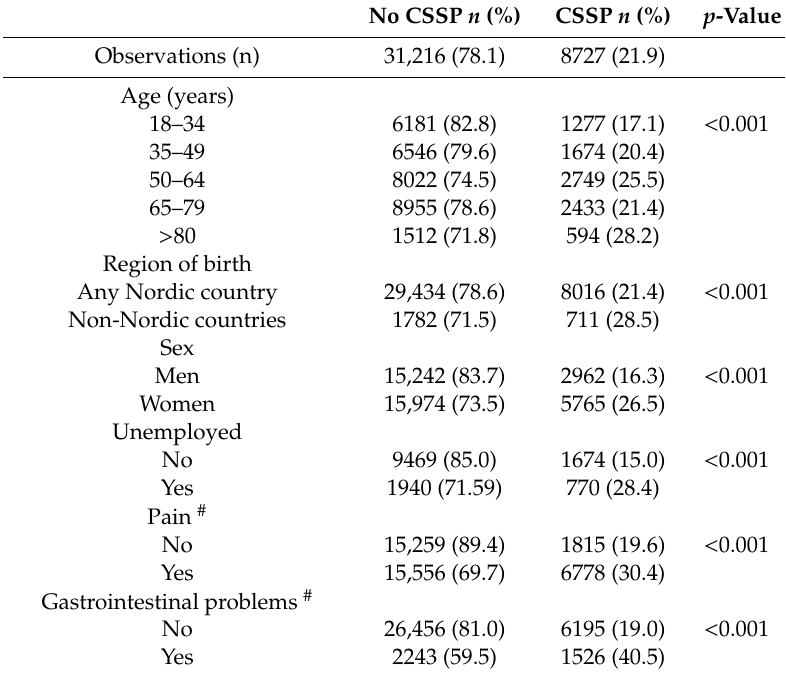
Table 1. Characteristics of the study population by no / mild sleep problems (no CSSP) and chronic severe sleep problems